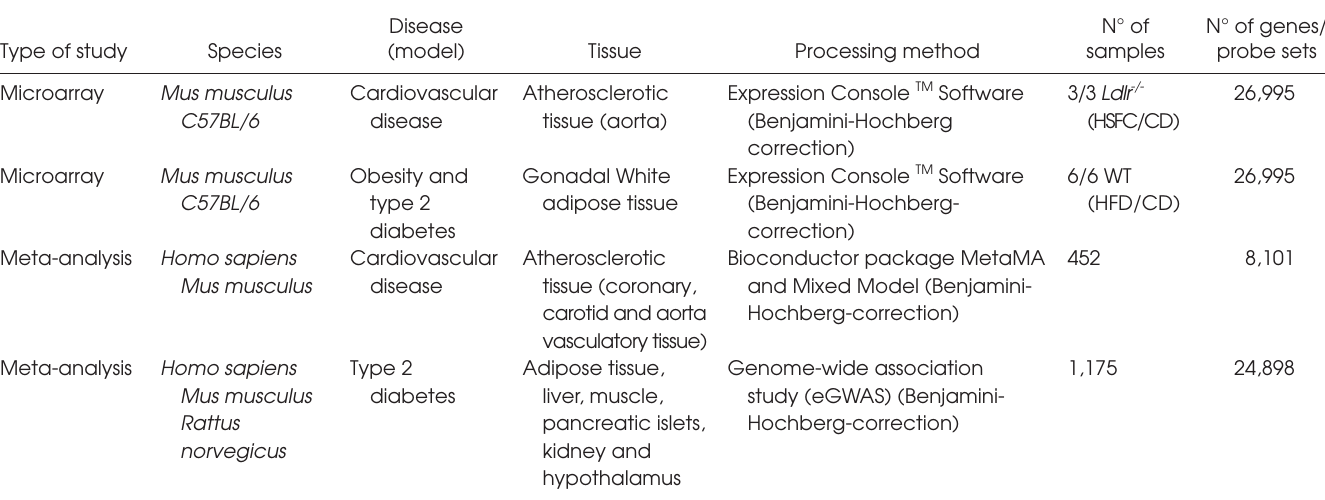
Table 1. Overview of the study